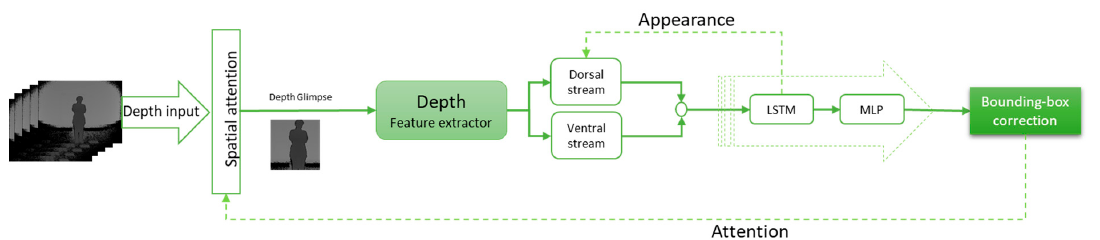
Figure 4. Depth tracker model. The glimpse is selected in spatial attention module, then using a CNN the appearance feature spatial feature is extracted and fed to LSTM from depth only.